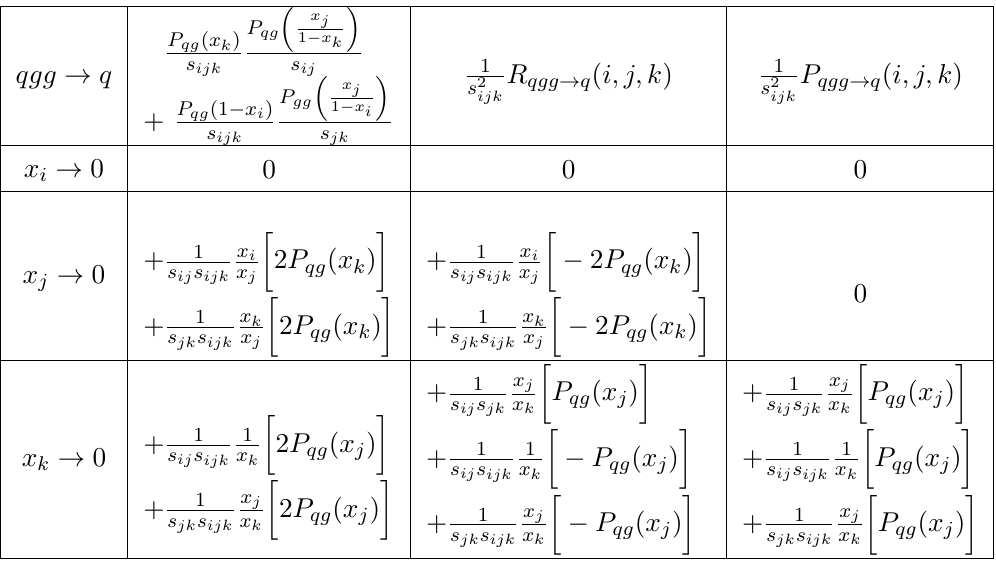
Table 2 . Singular behaviour of the P qgg → q triple collinear splitting function in the limit where individual momentum fractions are